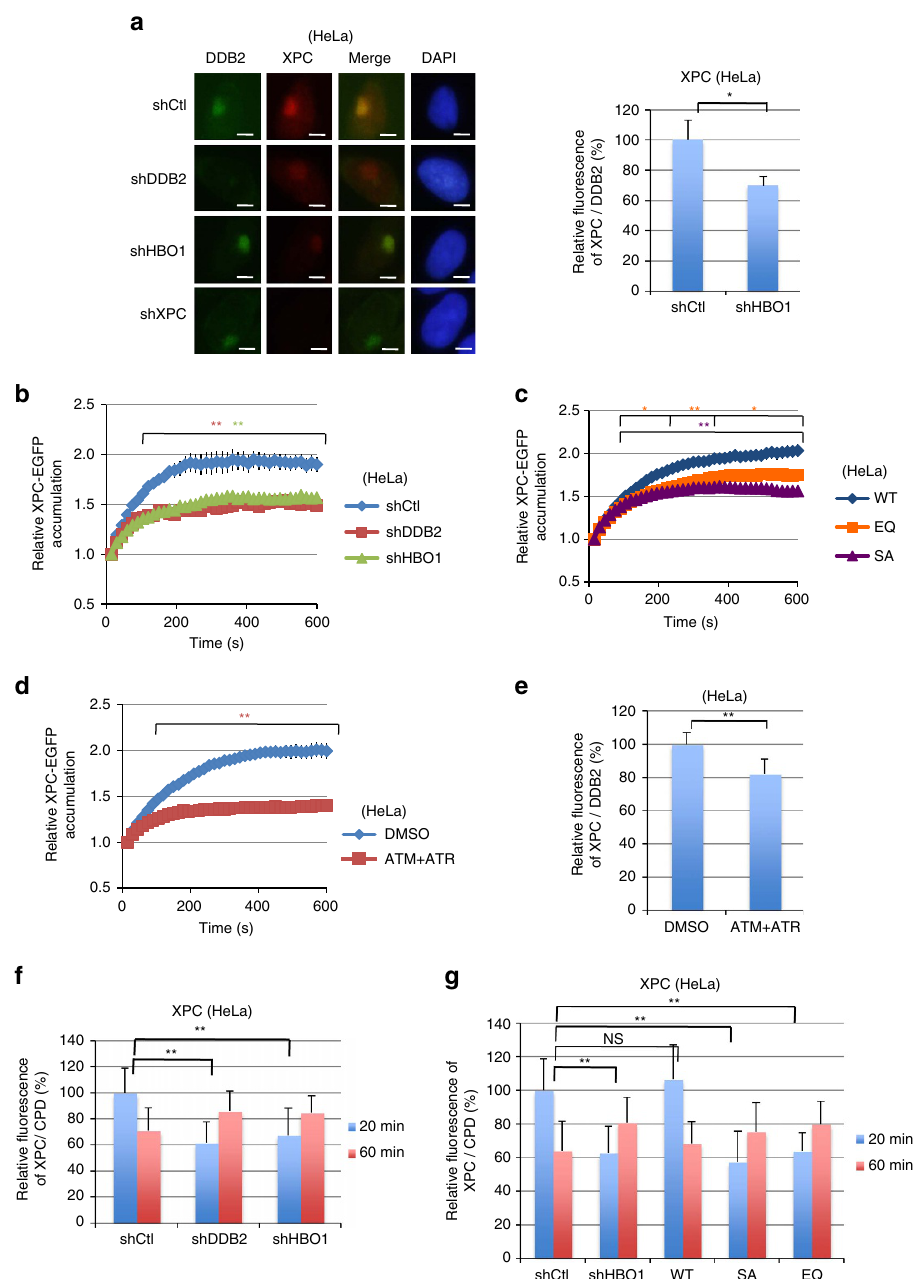
Figure 3 | XPC accumulation is decreased in HBO1-depleted cells. ( a ) Accumulation of XPC at damage sites was suppressed in shHBO1 cells. 50Jm (cid:2) 2 local ultraviolet-irradiated shCtl, shDDB2, shHBO1 and shXPC cells were incubated for 30min and subjected to immunostaining with anti-DDB2 and anti-XPC antibodies. The relative XPC/DDB2 intensity of shHBO1 cell is shown as % of shCtl cells. Scale bars, 5 m m. Cells ( n ¼ 50) from three independent experiments; error bars indicate means ± s.d. * P o 0.05 (Student’s t -test). ( b – d ) Live-cell imaging of XPC–EGFP accumulation at damage sites. Accumulation of XPC–EGFP was defective in shDDB2 cells and shHBO1 cells ( b ), shHBO1 cells stably expressing Myc-HBO1 EQ or SA ( c ), and ATM and ATR inhibitor-treated shCtl cells ( d ). XPC–EGFP was transiently transfected into shCtl, shDDB2 and shHBO1 cells and cells were irradiated with 405-nm laser in Hoechst 33342-containing medium. Quantification of accumulated XPC–EGFP was performed as described in Methods. Cells ( n ¼ 30) from three independent experiments; error bars are the mean ± s.e.m. * P o 0.05, ** P o 0.01 (Student’s t -test). ( e ) ATM and ATR inhibitor treatment suppressed XPC accumulation at ultraviolet-induced DNA damage sites. Cells were local irradiated with ultraviolet 50Jm (cid:2) 2 and cultured for 30min. The relative XPC/DDB2 intensity of ATM and ATR inhibitor-treated cells is shown as % of DMSO control cells. Cells ( n ¼ 50) from three independent experiments; error bars indicate means ± s.d. ** P o 0.01 (Student’s t -test). ( f , g ) Relative XPC accumulation at damage sites at 20 and 60min after 12Jm (cid:2) 2 ultraviolet irradiation was quantified and shown as % of shCtl cells after 20min ultraviolet. Cells ( n ¼ 50) from three independent experiments; error bars indicate means ± s.d. ** P o 0.01 (Student’s t